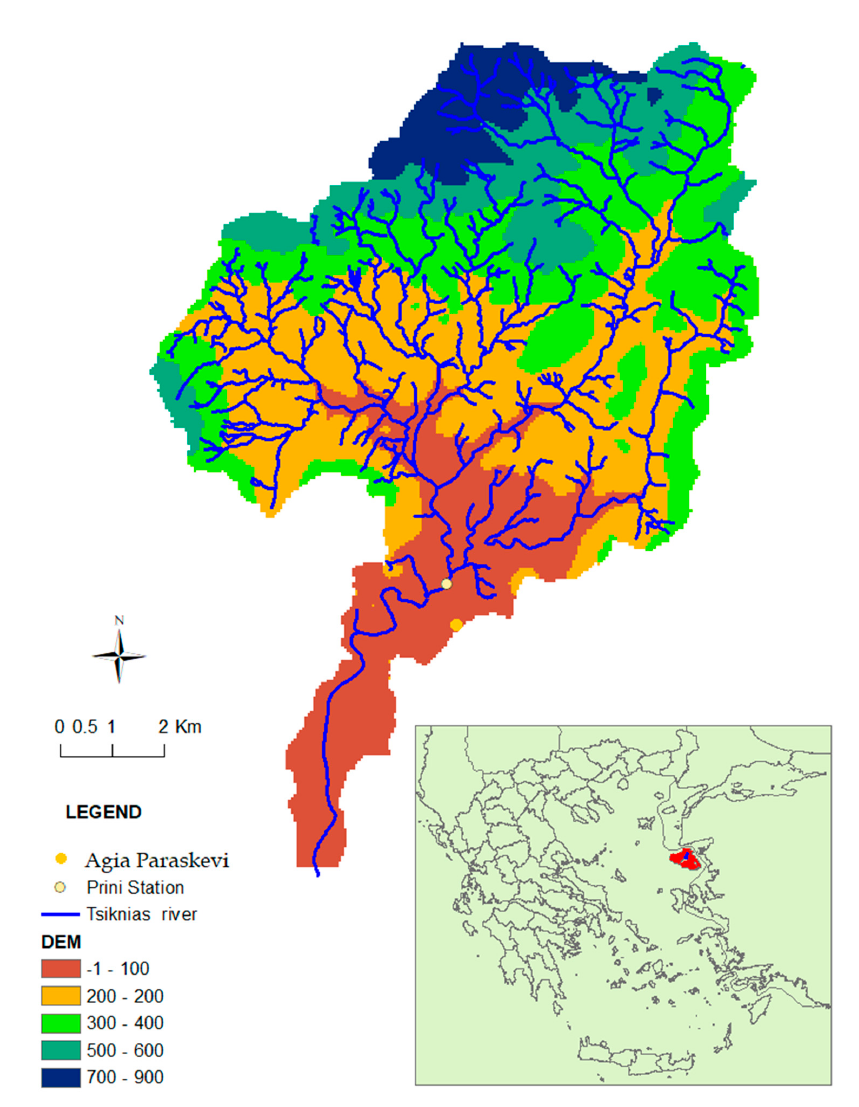
Figure 1. Tsiknias River hydrographic network and basin at Lesvos island in north-east Greece.